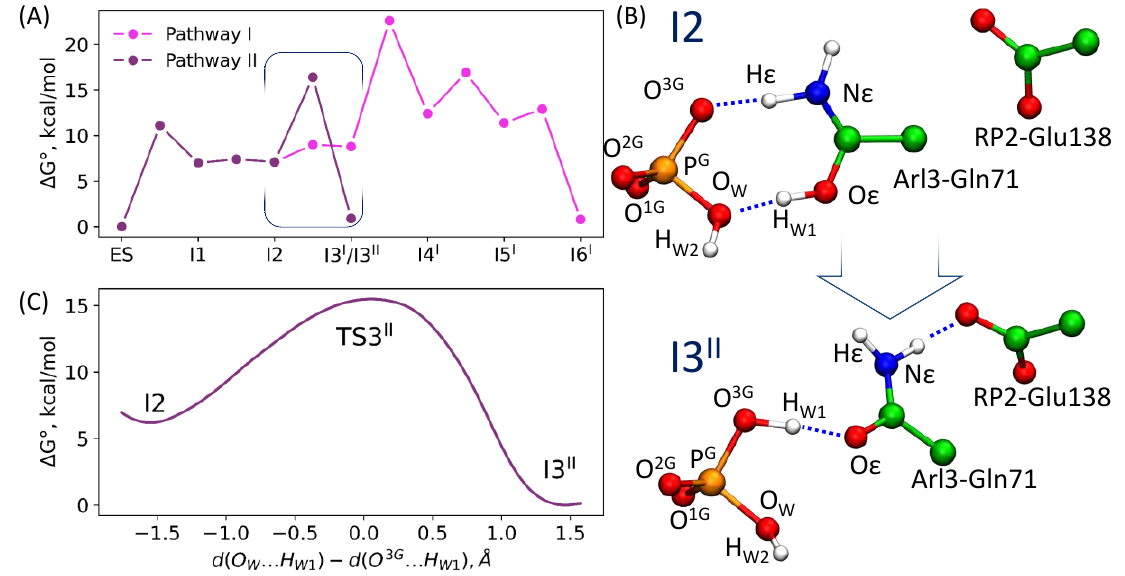
Figure 7. ( A ) Gibbs energy profiles of the reaction mechanisms recalculated by motifs of Ref. [26] (pathway I) and of the mechanism proposed in this study (pathway II); ( B ) The fragments of the active site corresponding to the I2 and I3 II conformations; ( C ) Gibbs energy profile of the I2 ⇌ I3 II transition.